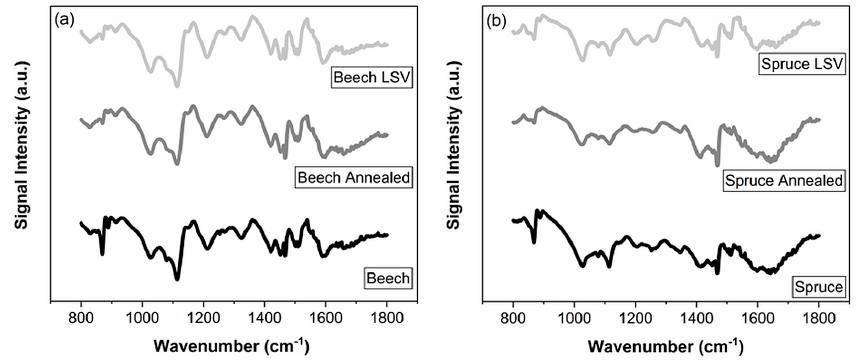
Figure 2. FTIR transmittance spectra of beech ( a ) and spruce ( b ) lignin samples in the characteristic fingerprint region.